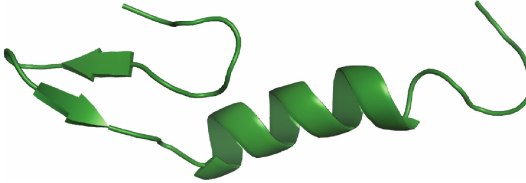
Figure 2: The NMR solution structure of leucocin A